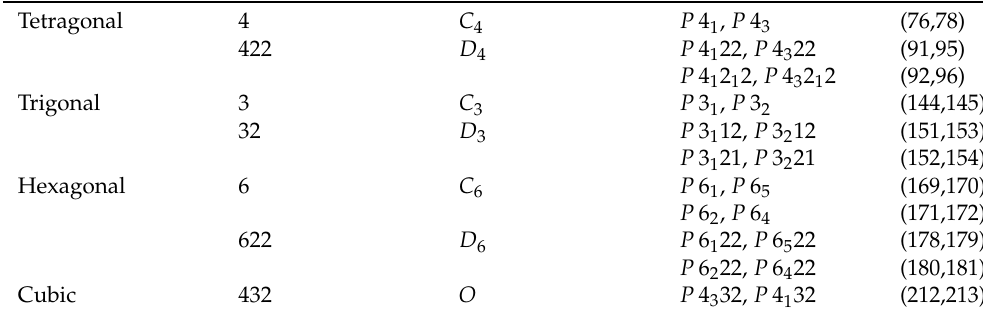
Figure 2. The 2-, 3-, 4-, and 6-fold screw axes. For each screw, the relative translation τ = n z axis after the rotation is assigned by an arrow. For the neutral axes a positive or negative rotation about the z -axis (e.g., rotation by ± π in case of the 2 1 screw rotation) yields the same result. Table 3. The 22 chiral space groups of class II in 11 enantiomorphous pairs (columns as in Table